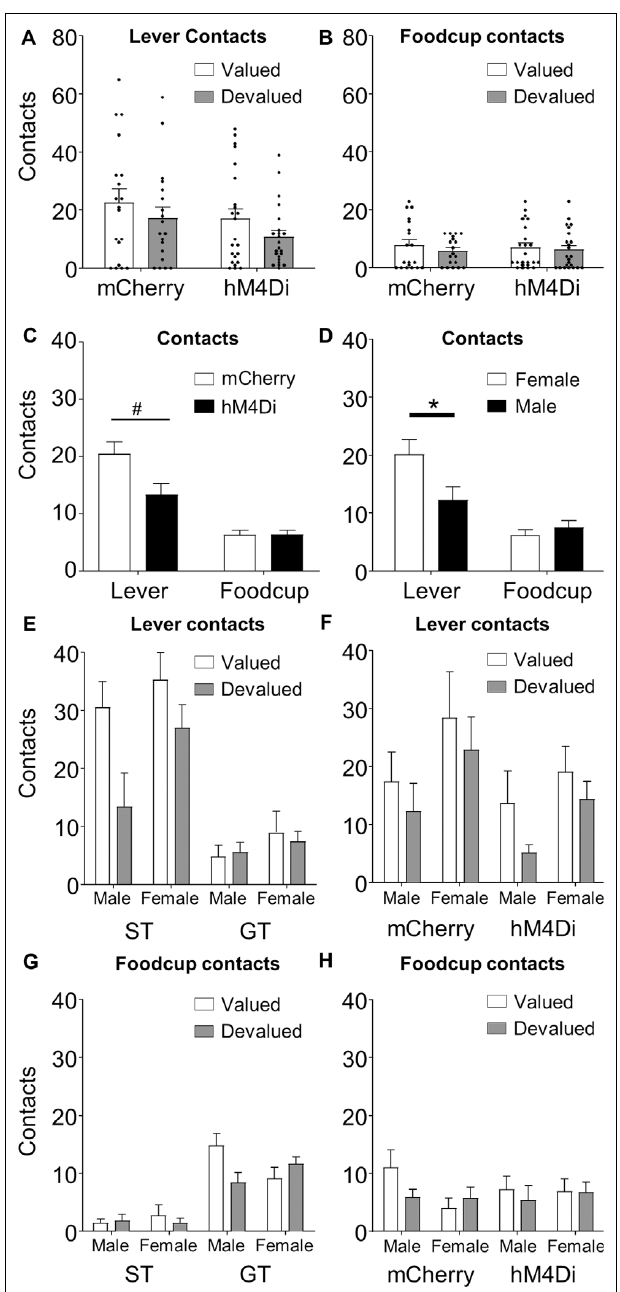
FIGURE 3 | Lever and foodcup contact data represent individual subjects (dot) and group averages (bars) + SEM for (A) lever (B) and foodcup contacts during outcome devaluation, collapsed across Tracking Group. (C) Data represent contacts collapsed across Tracking Group and Value; basolateral amygdala (BLA)–nucleus accumbens (NAc) core inactivation disrupts lever but not foodcup approach, F (1,34) = 4.484, p = 0.042. Post hoc tests revealed a trend toward an effect of inactivation on lever-directed responding, such that hM4Di rats pressed less than mCherry rats, t (22) = 2.05, # p = 0.053. Sex effects split by Response type (D) , Tracking Group (E,G) , and Virus group (F,H) . Data represent group averages (bars) + SEM. (D) Females perform more lever-directed responses than males during outcome devaluation tests overall. (G) Tracking Group × Value × Sex interaction of foodcup responding ( F (1,34) = 5.02, p = 0.032). *Indiciates significant difference with p <